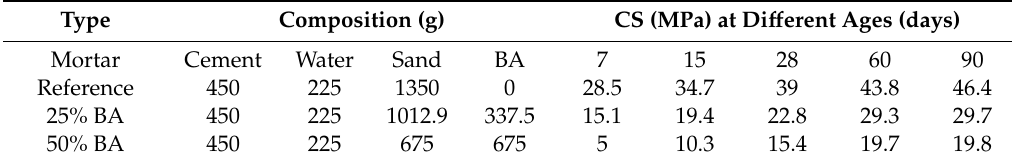
Table 4. Composition of the mortar mixture and compressive strength at di ff erent ages.